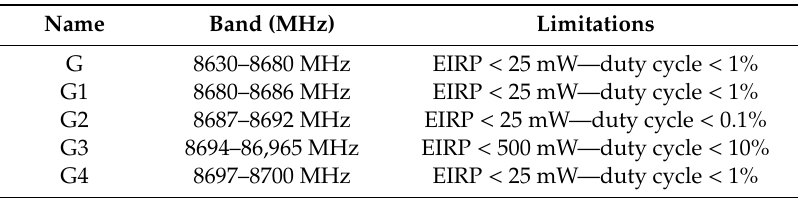
Table 2. Duty cycle restrictions on EU bands.